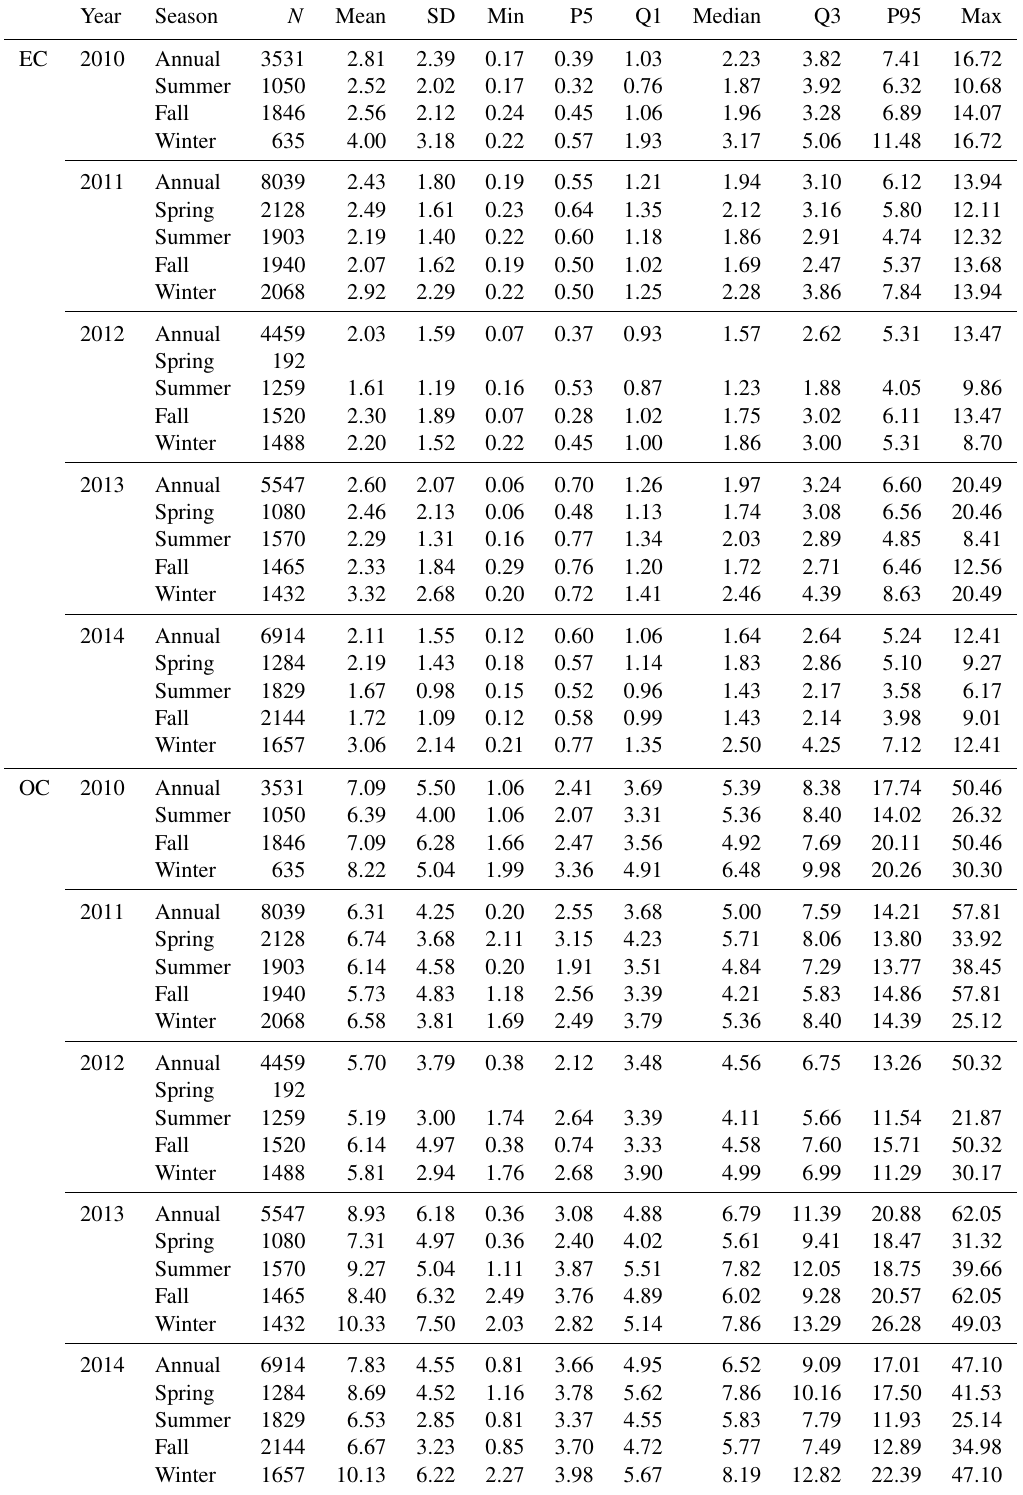
Table 1. Descriptive statistics of the annual and seasonal variations of EC, OC, and OC / EC during 10 July 2010–31 December 2014 in Shanghai. Note that the statistics results of spring 2012 are not given due to data